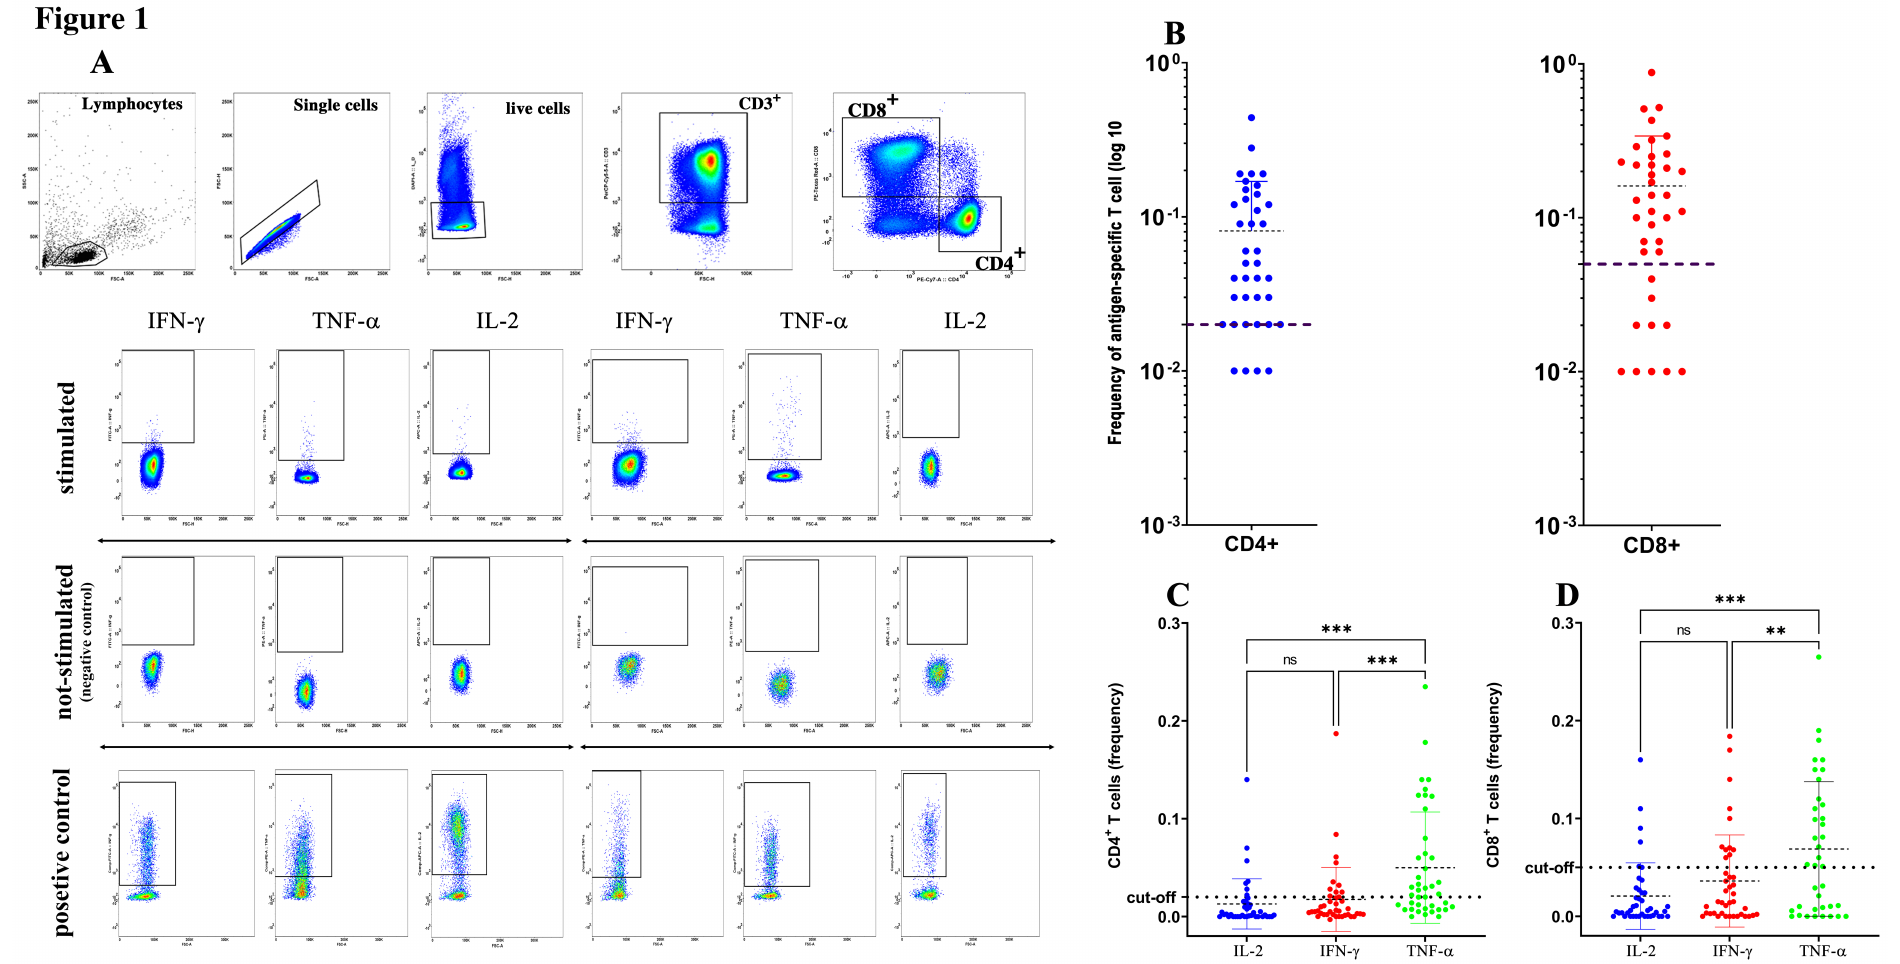
Figure 1. Quantification of spike-specific CD4 + and CD8 + T cells after SARS-CoV-2 vaccination. Gating strategy used to identify spike-specific CD4 + and CD8 + T cells and to detect their cytokine expression in response to spike-derived peptides. ( A )Cumulative frequency and distribution of spike-specific CD4 + and CD8 + T cells ( B ) in SARS-CoV-2-vaccinated individuals ( n = 40). Cut-off for positivity was set at <0.02 for CD4 + T cells and <0.05 for CD8 + T cells. Analysis of distinct cytokine expression by spike-specific CD4 + ( C ) and CD8 + ( D ) T cells using Kruskal–Wallis test with Dunn’s correction. ** p < 0.01; *** p < 0.001; ns: not